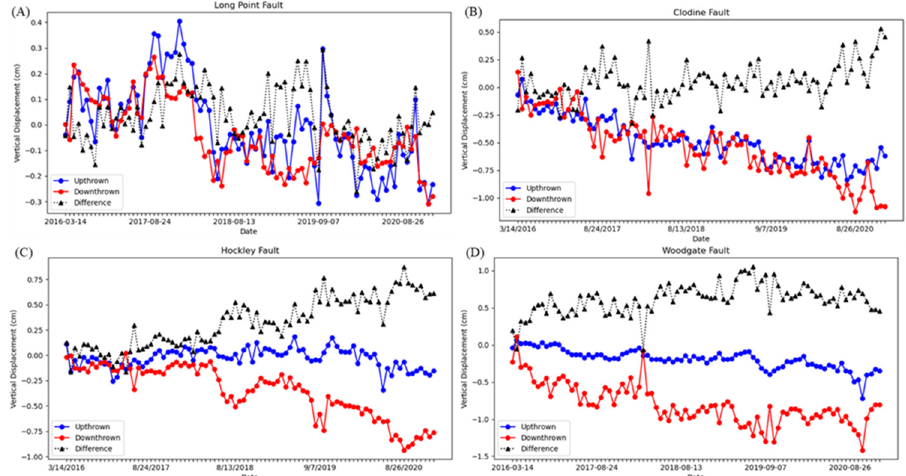
Figure 10. LOS displacement time series for downthrown and upthrown blocks of four faults. Data derived from the InSAR analysis from 2016 to 2020 for ( A ) Long Point Fault, ( B ) Clodine Fault, ( C ) Hockley Fault, and ( D ) Woodgate Fault. The sites used for the displacement time series are shown by red dots in Figure 7.